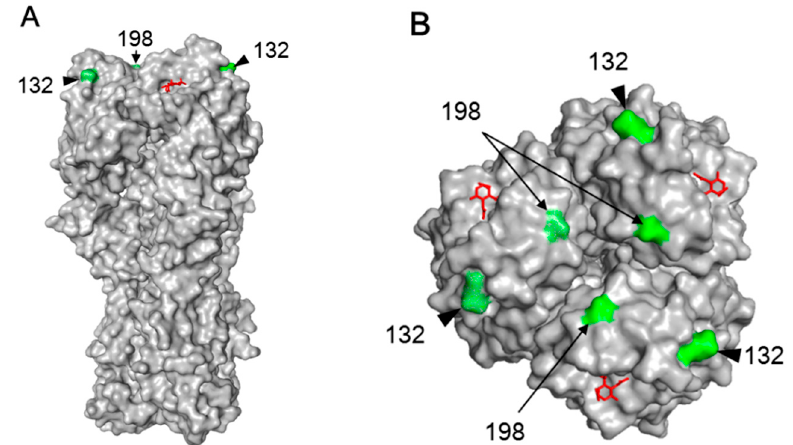
Figure 6. 3D structure of HA. Side-view of an HA trimer from H9N2 virus (PDB: 1JSH) ( A ) and its top-view ( B ). Amino acid positions 132 and 198 are colored green. The avian receptor analogue LSTa (LS-tetrasaccharide a: Neu5Ac( α 2-3)Gal( β 1-3)GlcNAc( β 1-3)Gal( β 1-4)Glc) is colored red.